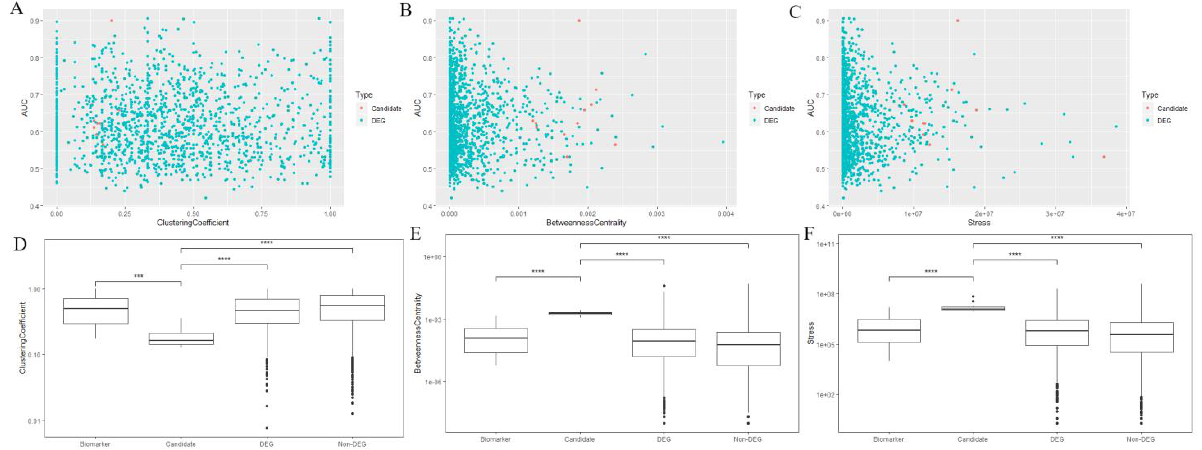
Figure 4. Comparison of the network features of predicted biomarker candidates with other genes. ( A – C ): Cluster coefficient ( A ), betweenness centrality ( B ), and stress ( C ) of candidate biomarkers (red points) and DEGs (green points) on CCS-PPIN. Biomarker candidates showed specific features in Cluster coefficient (0.125 – 0.25) and betweenness centrality (0.001 – 0.0025). ( D – F ): Boxplot of cluster coefficient ( D ), betweenness centrality ( E ), and stress ( F ) of the identified biomarkers, biomarker candidates, DEGs, and non-DEGs. Biomarker candidates showed significant differences with other genes.